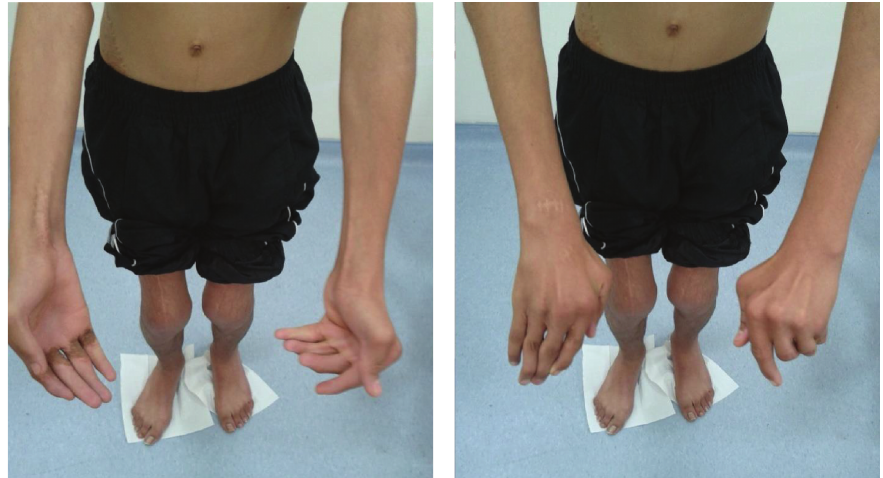
Figure 2: There were ulnar deviations in the fingers and flexion contractures in the proximal and distal interphalangeal joints of both hands. Fingers were thinner and longer than